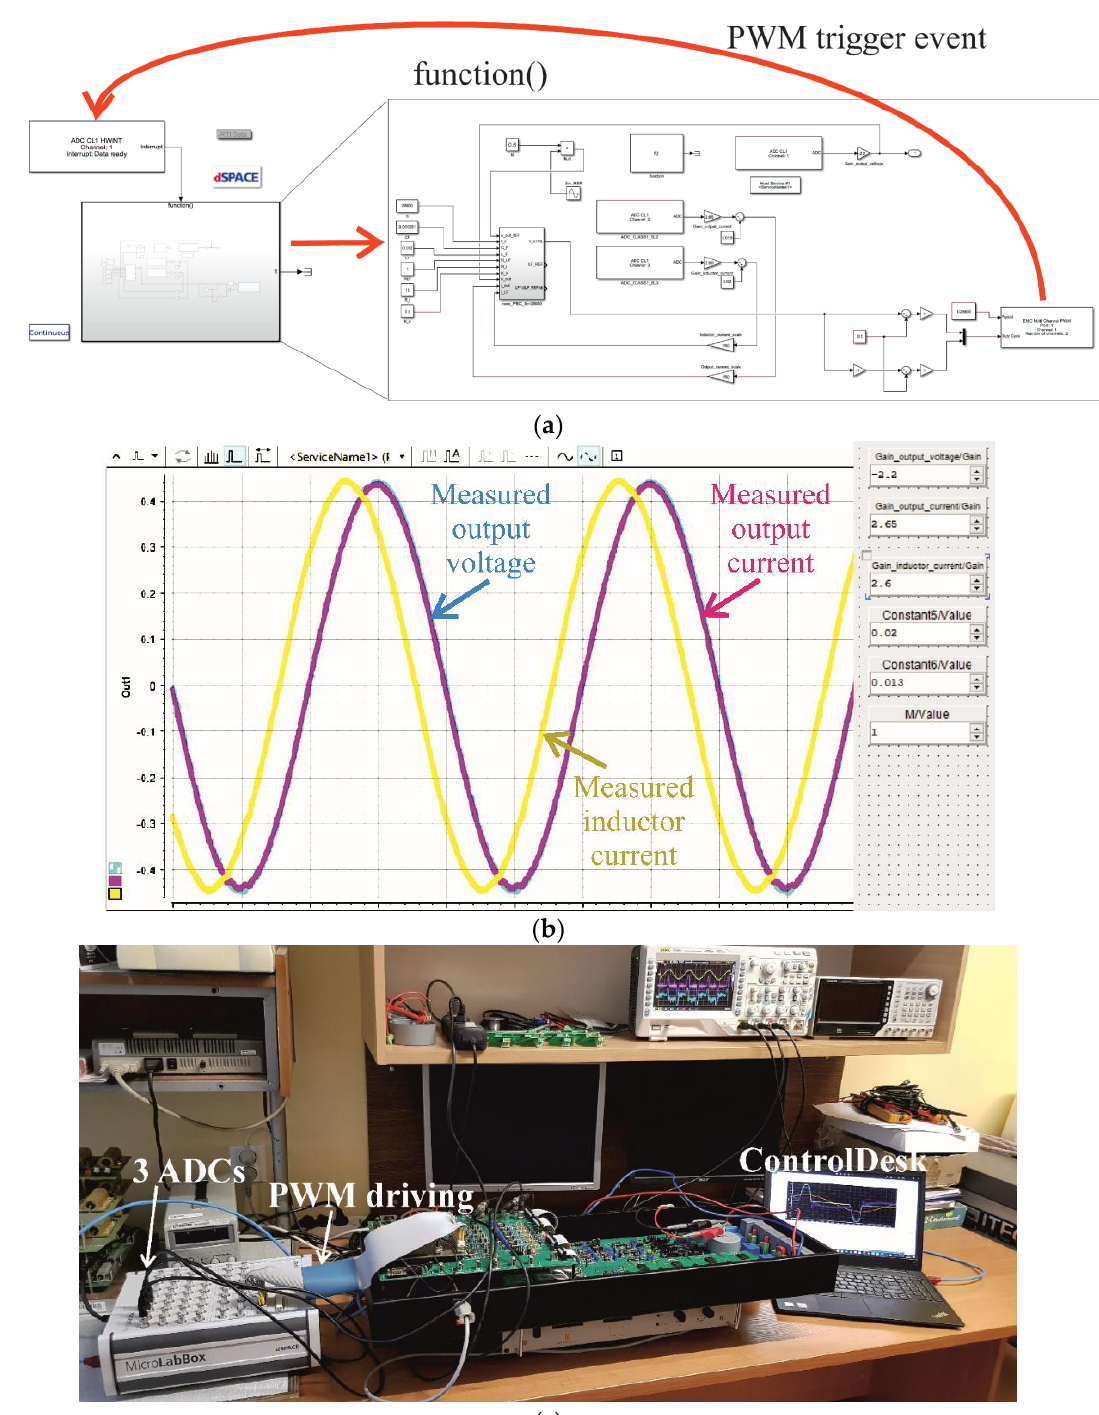
Figure 12. The MicroLabBox real-time interface between the dSpace simulation and the experimental VSI, showing ( a ) the combined Simulink and dSpace simulation model for MicroLabBox (RTI1202) operation, ( b ) scaling of the measuring traces using ControlDesk, and ( c ) an image of the experimental setup showing the three ADCs, the PWM driver, and ControlDesk running on a laptop.